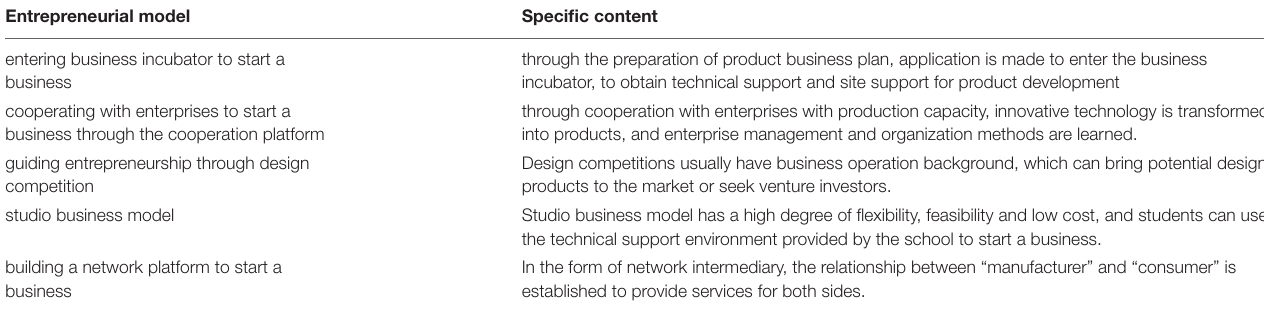
TABLE 4 | Entrepreneurial model of achievement transformation practice. Entrepreneurial model Specific